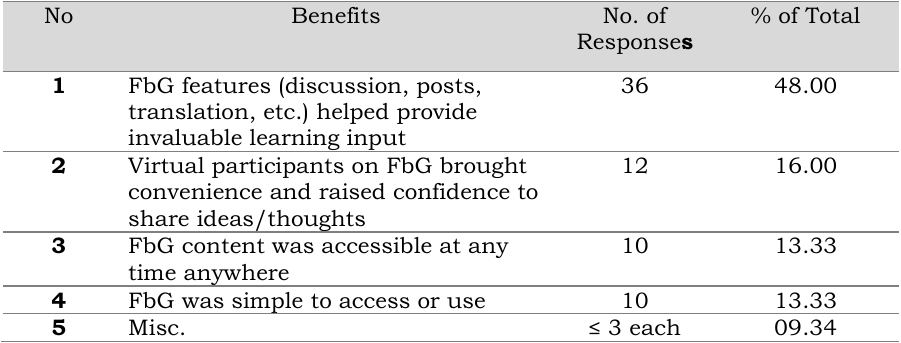
Table 2. Benefits of FbG usage in essay writing according to